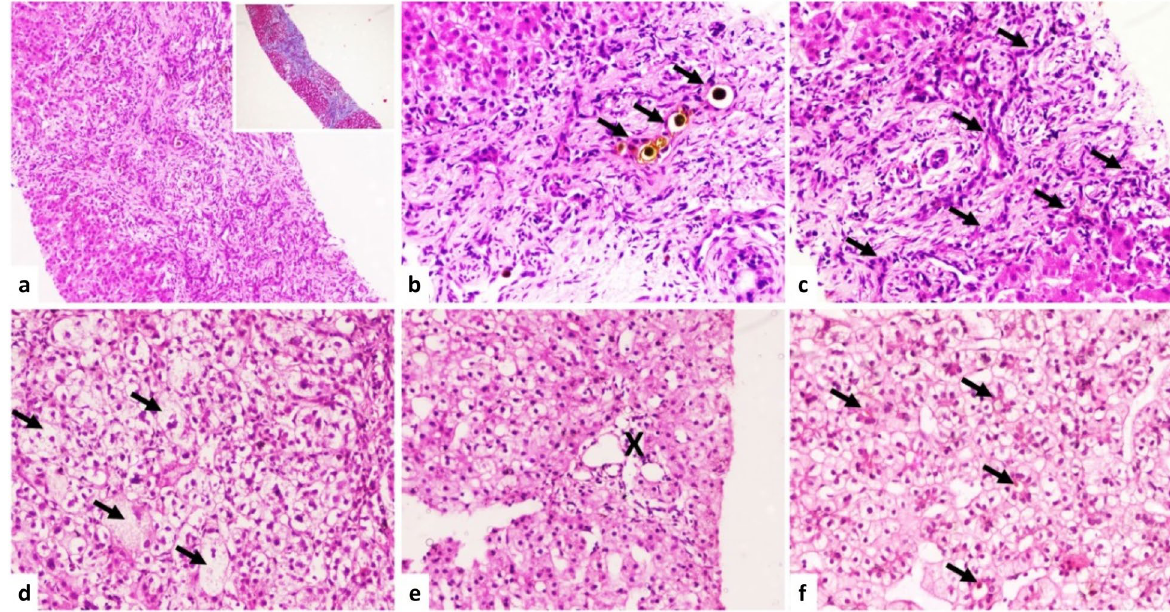
Fig. 1 Histopathological characteristics of biliary atresia versus non‑biliary atresia cholestatic diseases. a A case of biliary atresia showing marked portal tract expansion by edema (H&E 100 ) and fibrosis (incite, Masson trichrome 40 ). b A case of biliary atresia showing pathognomic × × intraluminal bile plugs (arrows) (H&E 200 ). c A case of biliary atresia showing bile ductular proliferation (arrows) (H&E 200 ). d A case of giant × × cell hepatitis showing numerous giant cell transformations (arrows) (H&E 200 ). e A case of Alagille syndrome showing lacks of the main bile duct × branch, not accompanying the artery (X mark) (H&E 200 ). f A case of progressive familial intrahepatic cholestasis showing prominent hepatic × rosetting with cholestatic rosettes formation (arrows) (H&E 200 ×